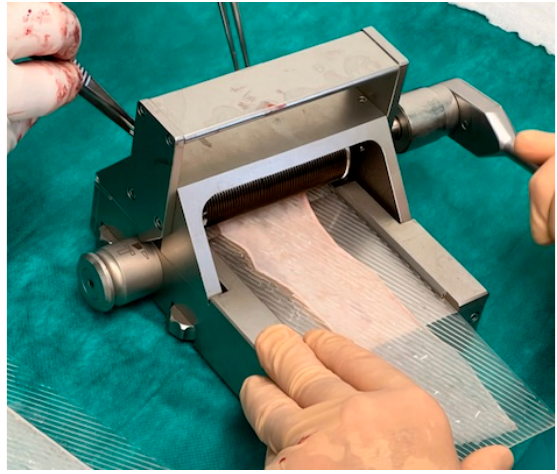
Figure 4. Split-skin transplant is converted into a network by a mesh graft dermatome.